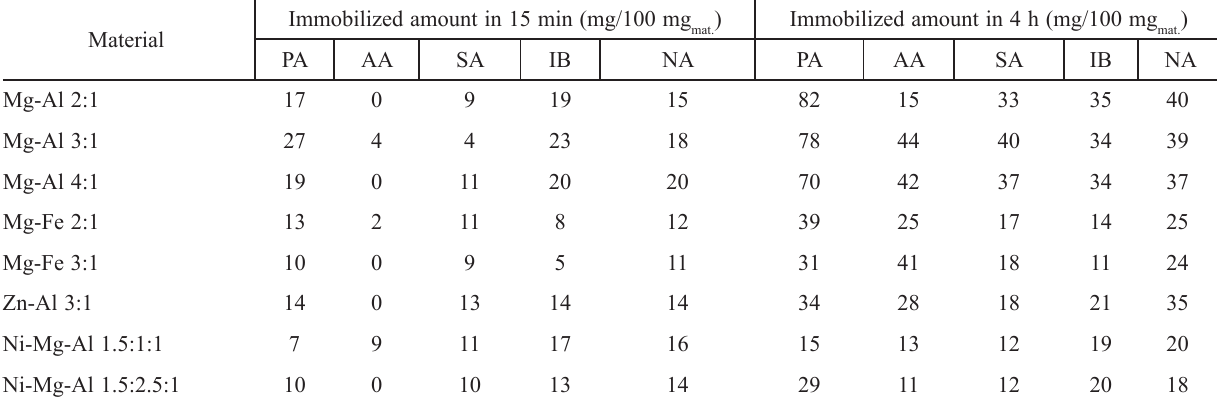
Table 2 – Immobilized amounts during immobilization (AA, PA: 100 mg substance, 100 mg mixed oxide; NA, SA, IB: 20 mg substance, 50 mg mixed oxide; 10 mL of demineralized water, 900 rpm, 4 h)